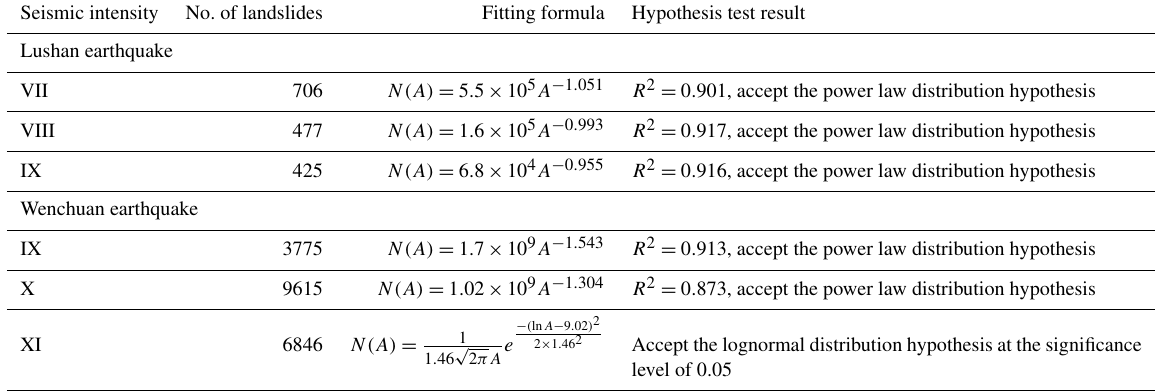
Table 2. Landslide frequency–area distributions in different seismic intensity zones. Seismic